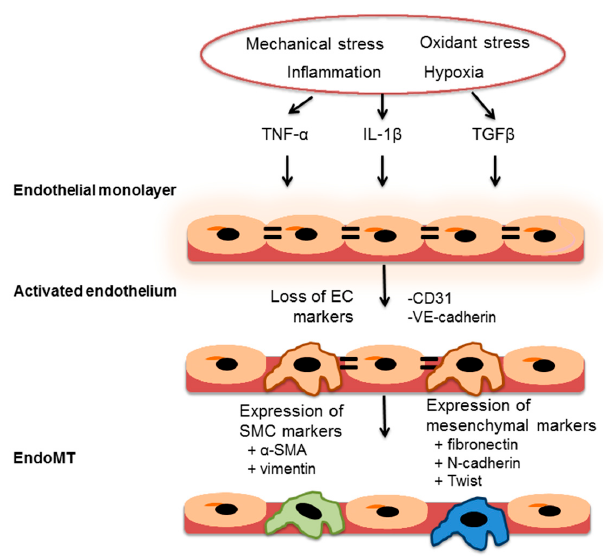
Figure 2. Endothelial-to-mesenchymal transition. Endothelial-to-mesenchymal transition (EndoMT) occurs when the endothelium is exposed to environmental stressors that increase levels of transforming growth factor- β (TGF β ), tumor necrosis factor- α (TNF- α ), or interleukin-1 β (IL-1 β ). These factors activate a select population of endothelial cells, which lose their endothelial markers ( i.e. , CD31, vascular endothelial cadherin (VE-cadherin), and von Willibrand factor (vWF)) and lose tight gap junctions between cells (double lines). These endothelial cells then express α -smooth muscle actin ( α -SMA) and vimentin. Cells may also acquire a mesenchymal phenotype and express fibronectin, N-cadherin, and the EndoMT-related transcription factor Twist. In the SU-5416/hypoxia model of pulmonary hypertension, investigators found that 6% ± 1% of endothelial cells in pulmonary arteries were positive for α -smooth muscle actin, suggesting EndoMT. This phenomenon was also observed in explanted lungs from patients with systemic